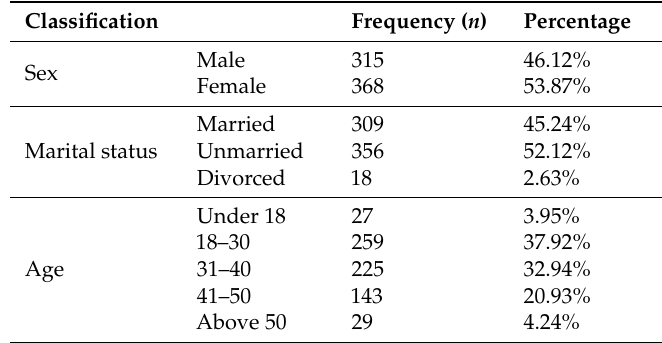
Table 1. Demographics of study